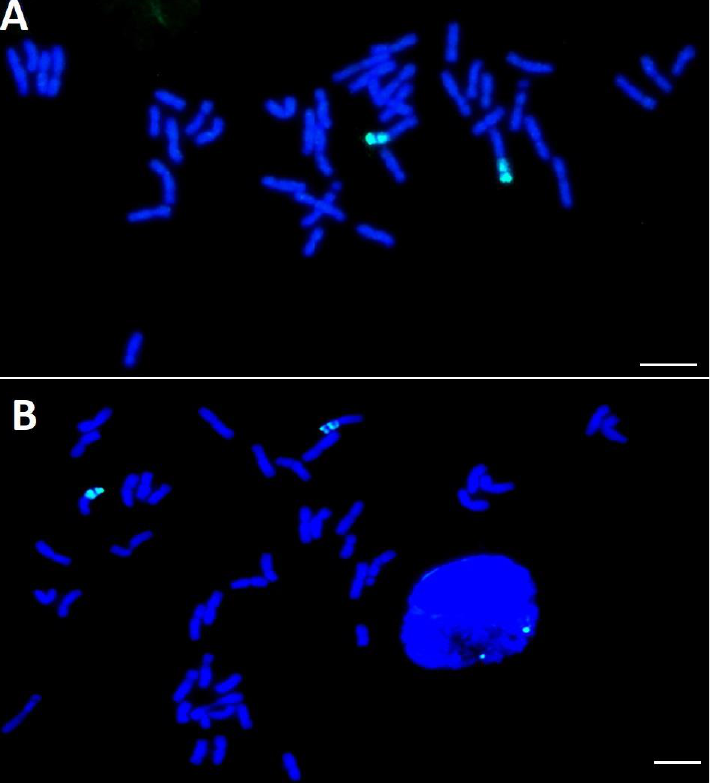
Figure 3. Genomic in situ hybridization on the chromosome spreads of winter bread wheat cultivar Vassa ( A ), and line 2318h9-4-28 ( B ). Green signals indicate rye chromatin , scale bar indicates 10 μm .